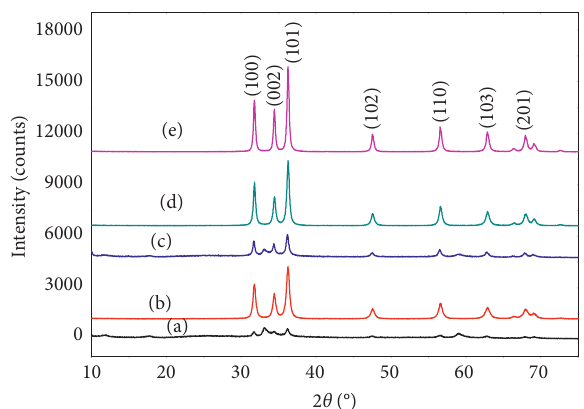
Figure 2: XRD patterns of ZnO NPs synthesized using zinc acetate dihydrate and Lippia adoensis leaf extract of different ratios by volume. (a) 1:1 (uncalcinated). (b) 1:1. (c) 3:2 (uncalcinated). (d) 3 :2. (e)